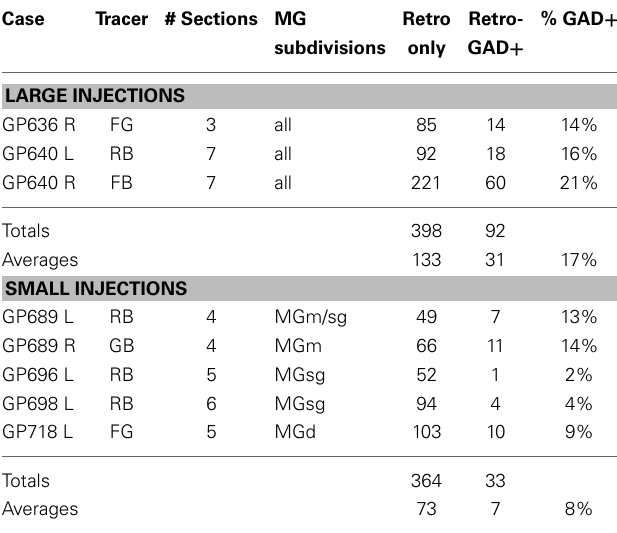
Table 3 | Percentage of retrogradely labeled NBIC cells that are GAD-immunopositive (GAD +